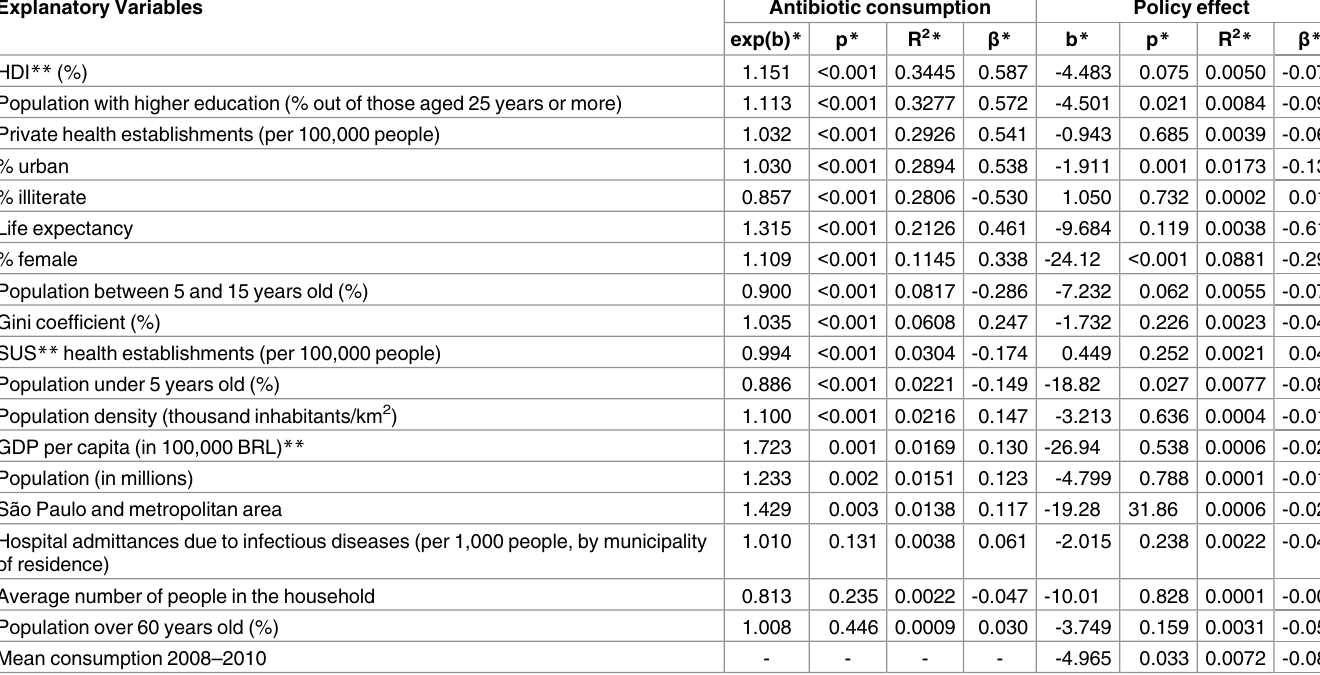
Table 2. Linear regression results for univariate